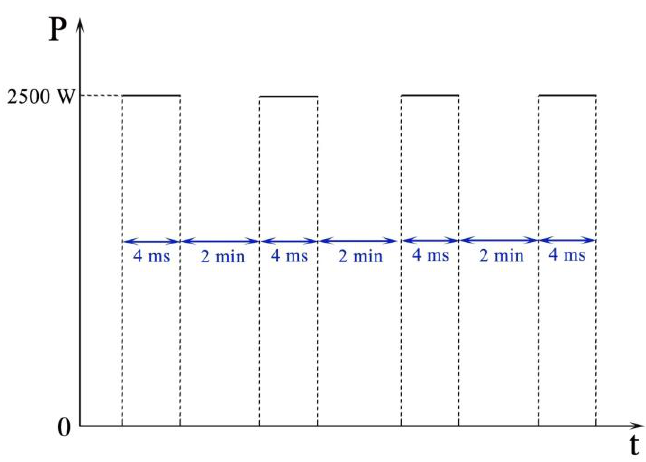
Figure 2. Pulse shape of the applied laser beam.